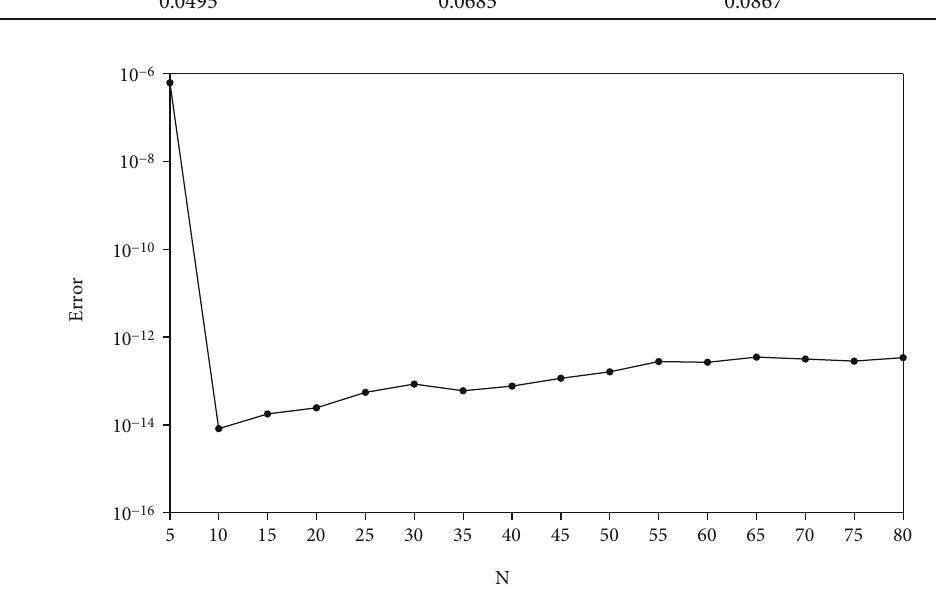
Figure 2: Absolute errors of u ð x Þ varied N for Example